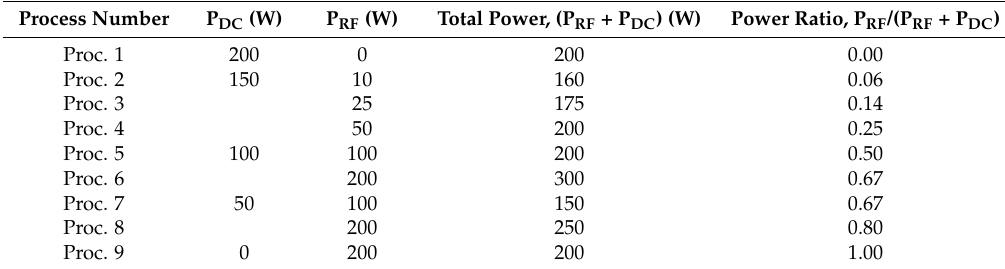
Table 1. Process number, DC power (P DC ), RF power (P RF ), total power (P RF + P DC ), and ratio of P RF to total power (P RF /(P RF + P DC